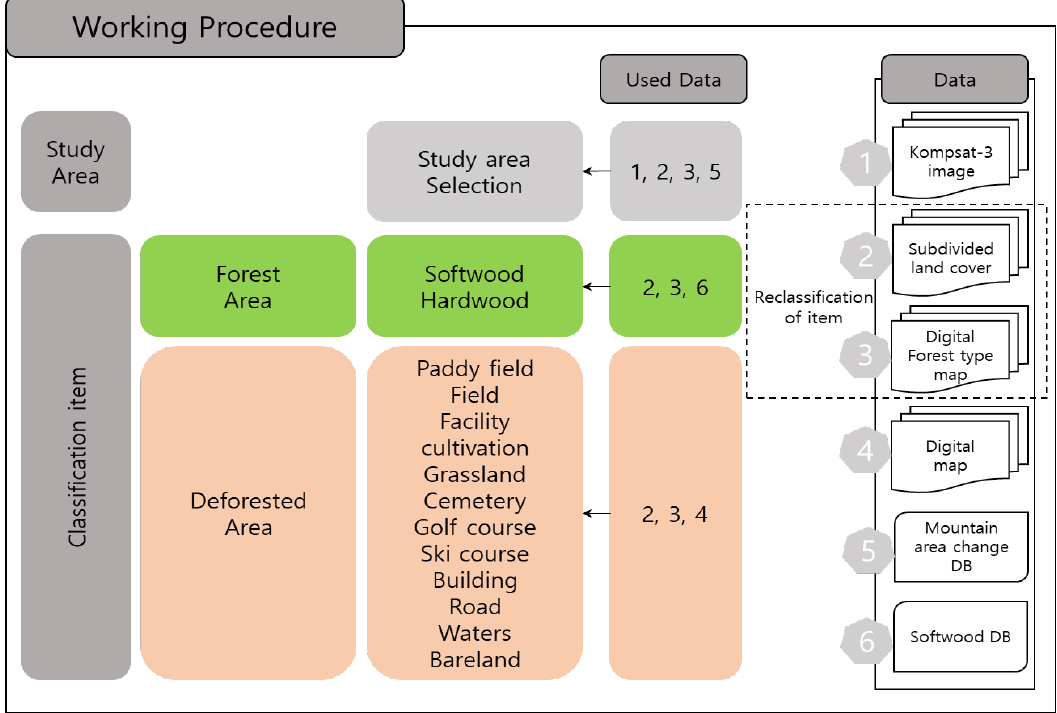
Figure 5. Working procedure and using data for the construction label dataset.